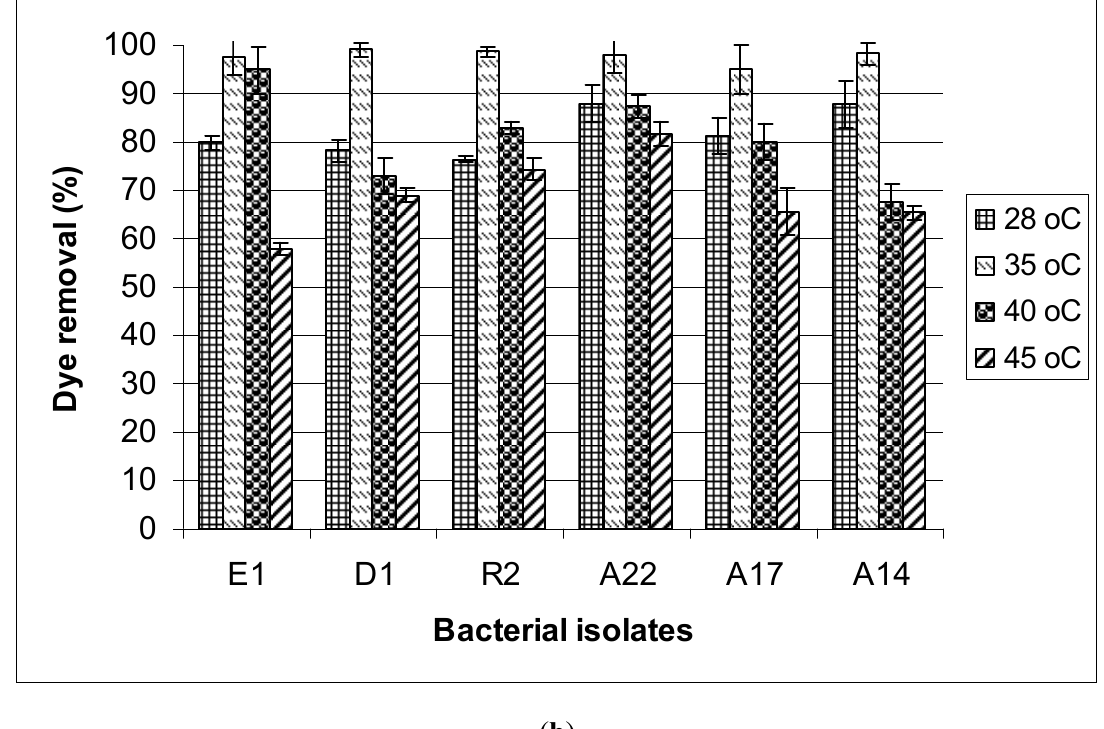
Figure 3. Effects of temperature on the removal of ( a ) whale dye; ( b ) mediblue dye; ( c ) fawn dye; and ( d ) mixed dye from textile industrial effluents. ( a